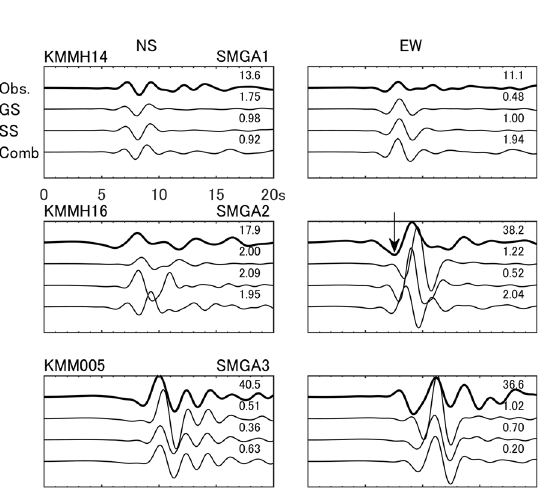
target sites, except for the NS component at KMMH14, which is the site under the direct influence of SMGA1.